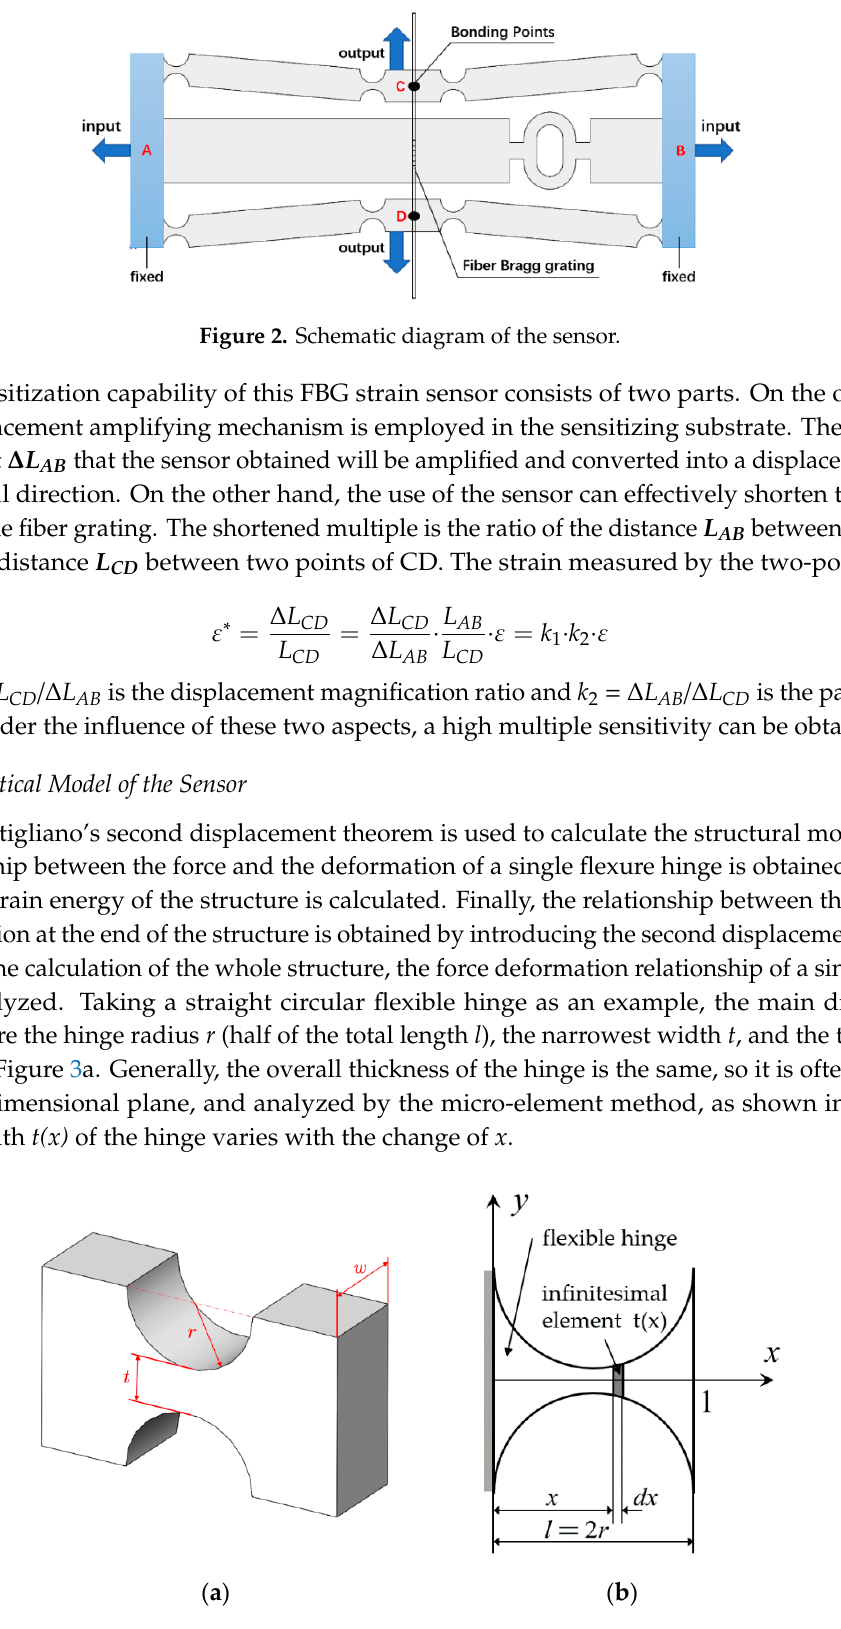
Figure 2. Schematic diagram of the sensor.